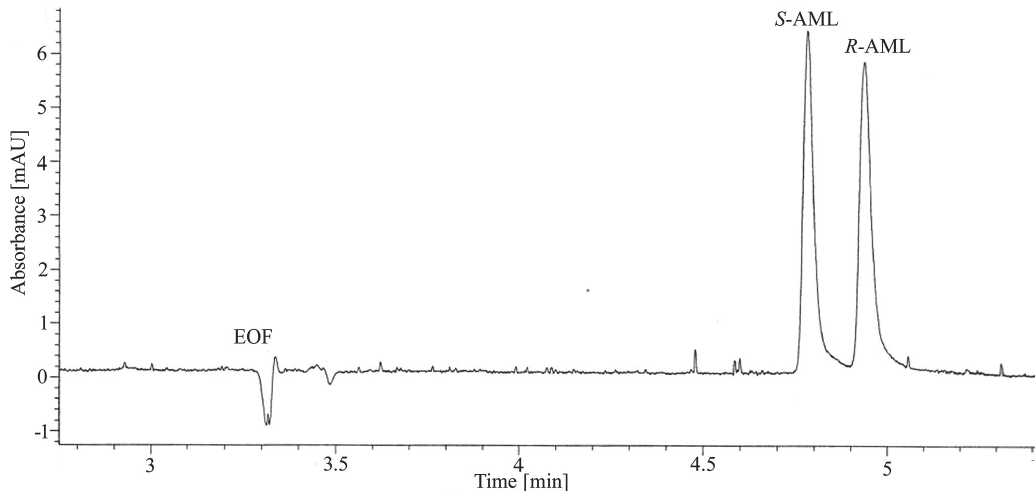
FIGURE 3 - Chiral separation of AML enantiomers under optimized electrophoretic conditions (analytical conditions: 25 mM phosphate, pH 9.0, 15 mM CM-β-CD, +25 kV, 15 °C, 30 mbar/1 second, UV 230